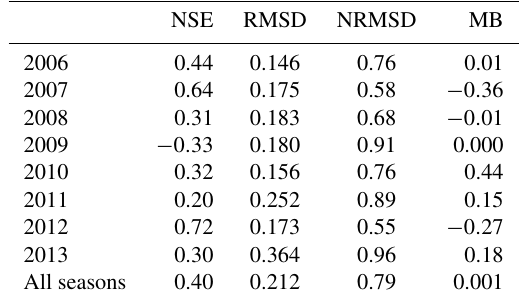
Table 4. Evaluation of simulated daily mean streamflow discharge for Marmot Creek using Nash–Sutcliffe efficiency (NSE), RMSD (m 3 s − 1 ), NRMSD, and